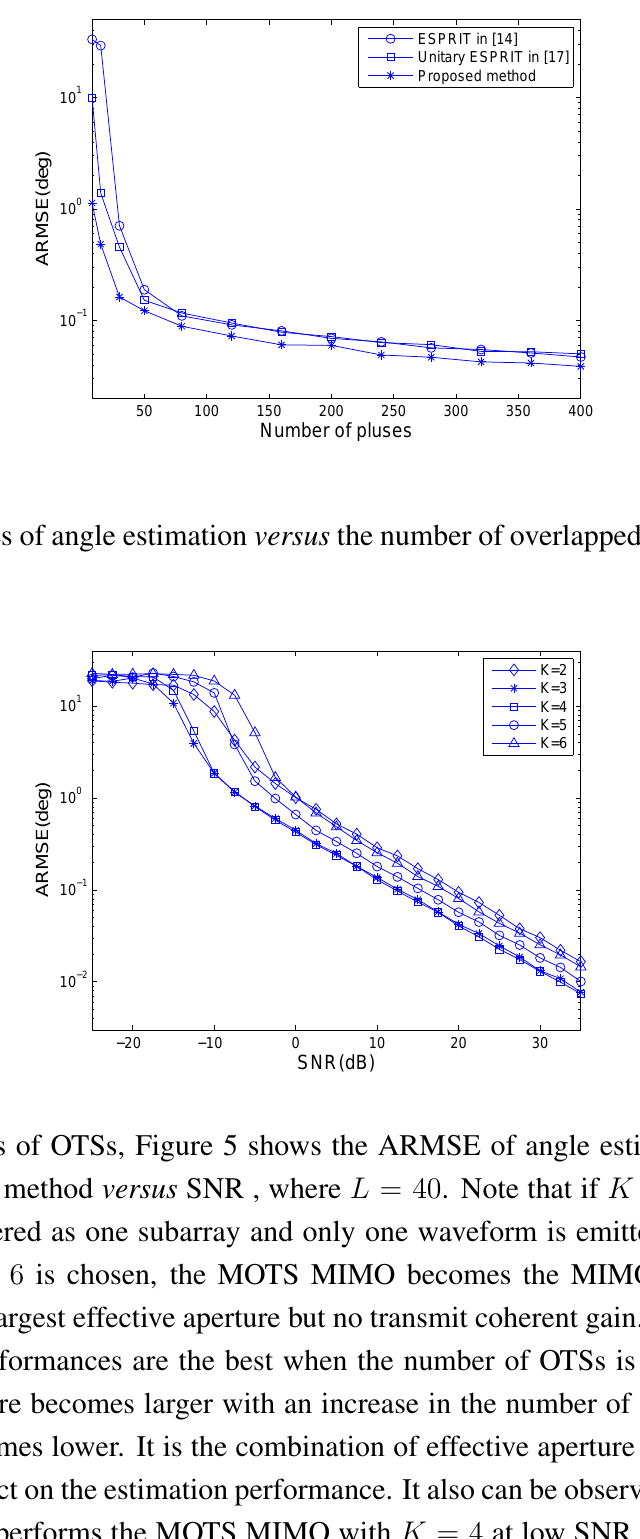
Figure 4. ARMSEs of angle estimation versus the number of pulses.